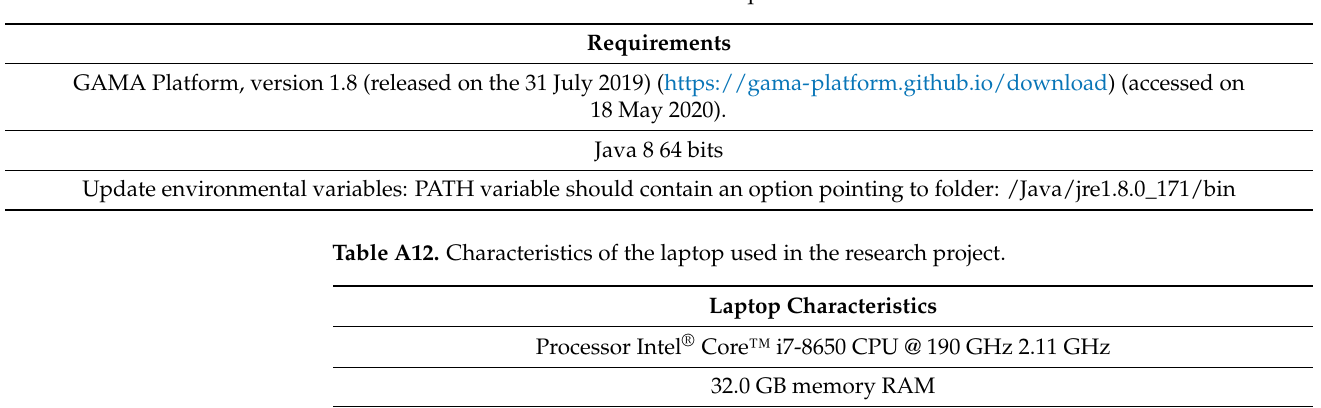
Table A11. ABM software requirements.